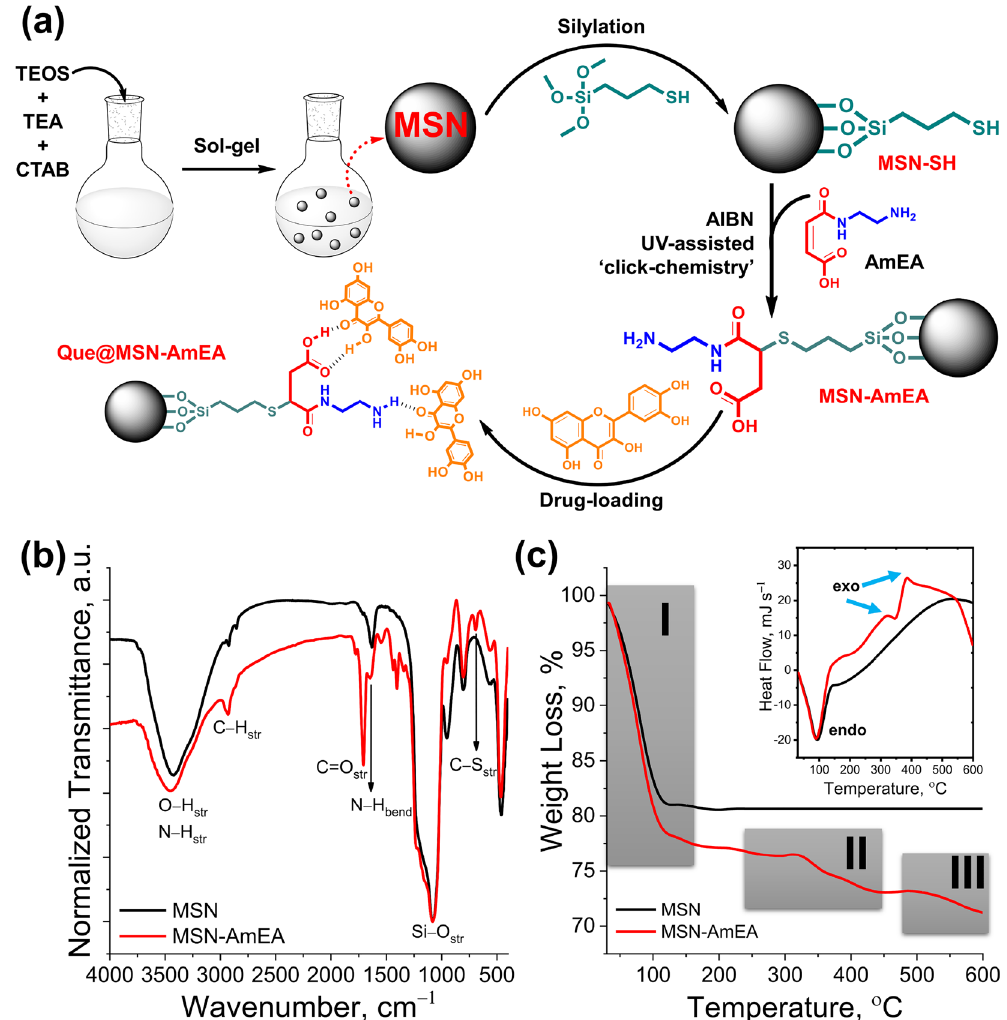
Figure 2. ( a ) Illustration synthesis of MSN-AmEA via thiol-ene ‘click chemistry’ consisted of MSN synthesis through the sol–gel method, silylation of MSN to introduce thiol group and chemically conjugated AmEA by the thiol-ene reaction. The scheme also presents the plausible interaction between quercetin and MSN-AmEA through hydrogen bond interaction (created by using ChemDraw Professional version 20.0.0.41, https:// www. cambr idges oft. com/ Ensem ble_ for_ Chemi stry/ ChemO ffice/ ChemO ffice Profe ssion al). ( b ) FTIR spectra of MSN and MSN-AmEA indicate a successfulness of AmEA conjugation onto MSN surfaces. ( c ) TGA and DSC (inserted box) curves of MSN-AmEA exhibit an additional two-stage degradation undergoing exothermic thermal